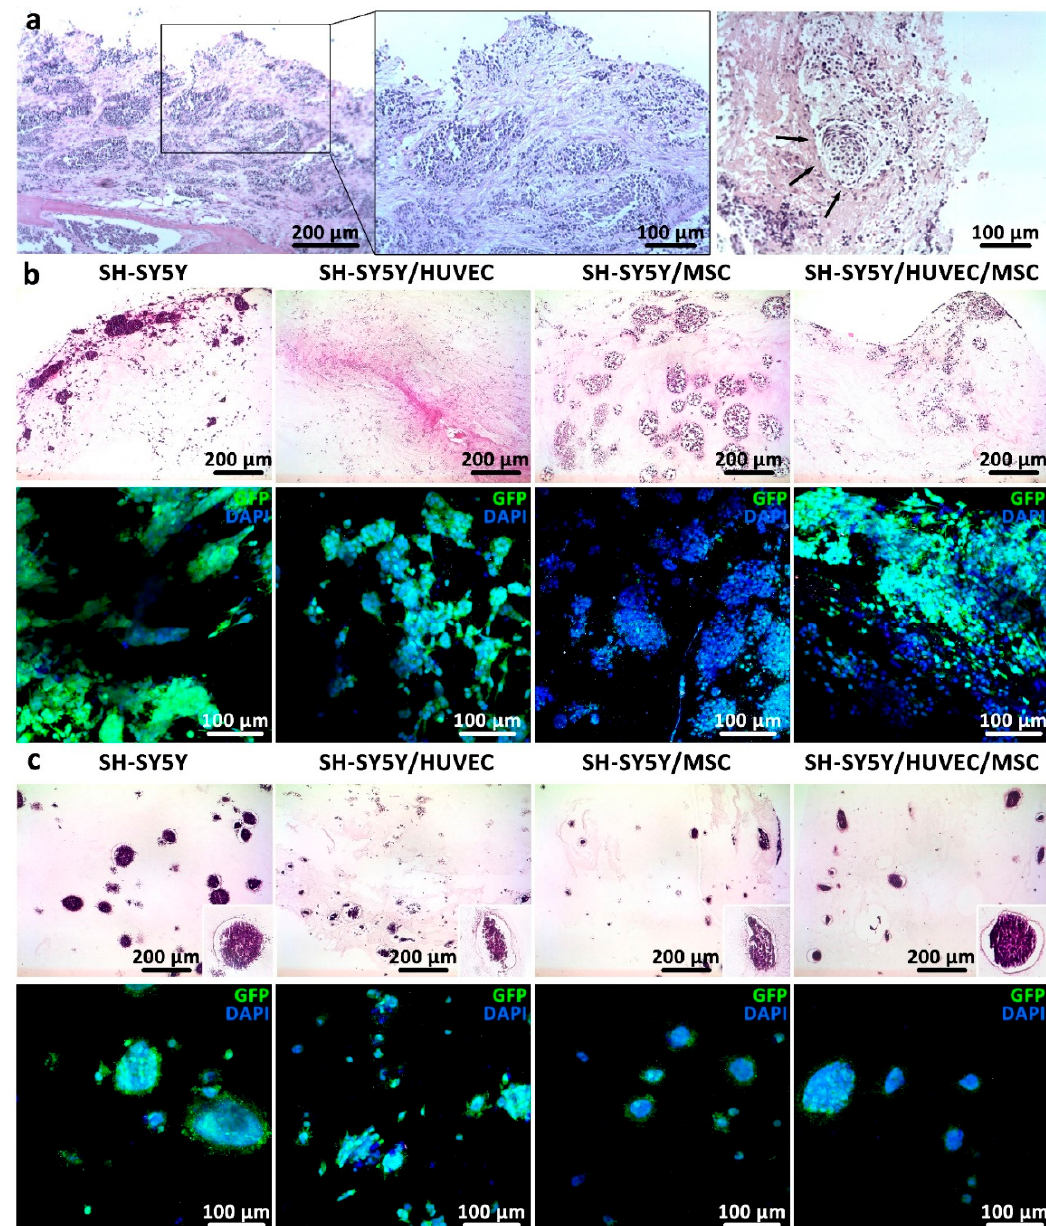
Figure 4. Cancer cells formed Homer Wright-like rosettes in bioprintable bioinks as they do in human neuroblastoma tissue. ( a ) Histological section of human neuroblastoma tumors from two high-risk patients were stained with HE. The tumor masses were examined under light microscope with 10× (first image on the left) and 20× (two images on the right) magnification. Arrows indicate Homer Wright-like rosettes structures. ( b – c ) Histological sections (first row) and immunocytochemical images (second row) of ( b ) 0.3% COL and ( c ) 0.2% COL-0.5% AG after 14 days of in vitro culture show organization of tumor and nontumor cells in non-bioprintable and bioprintable hydrogels, respectively.